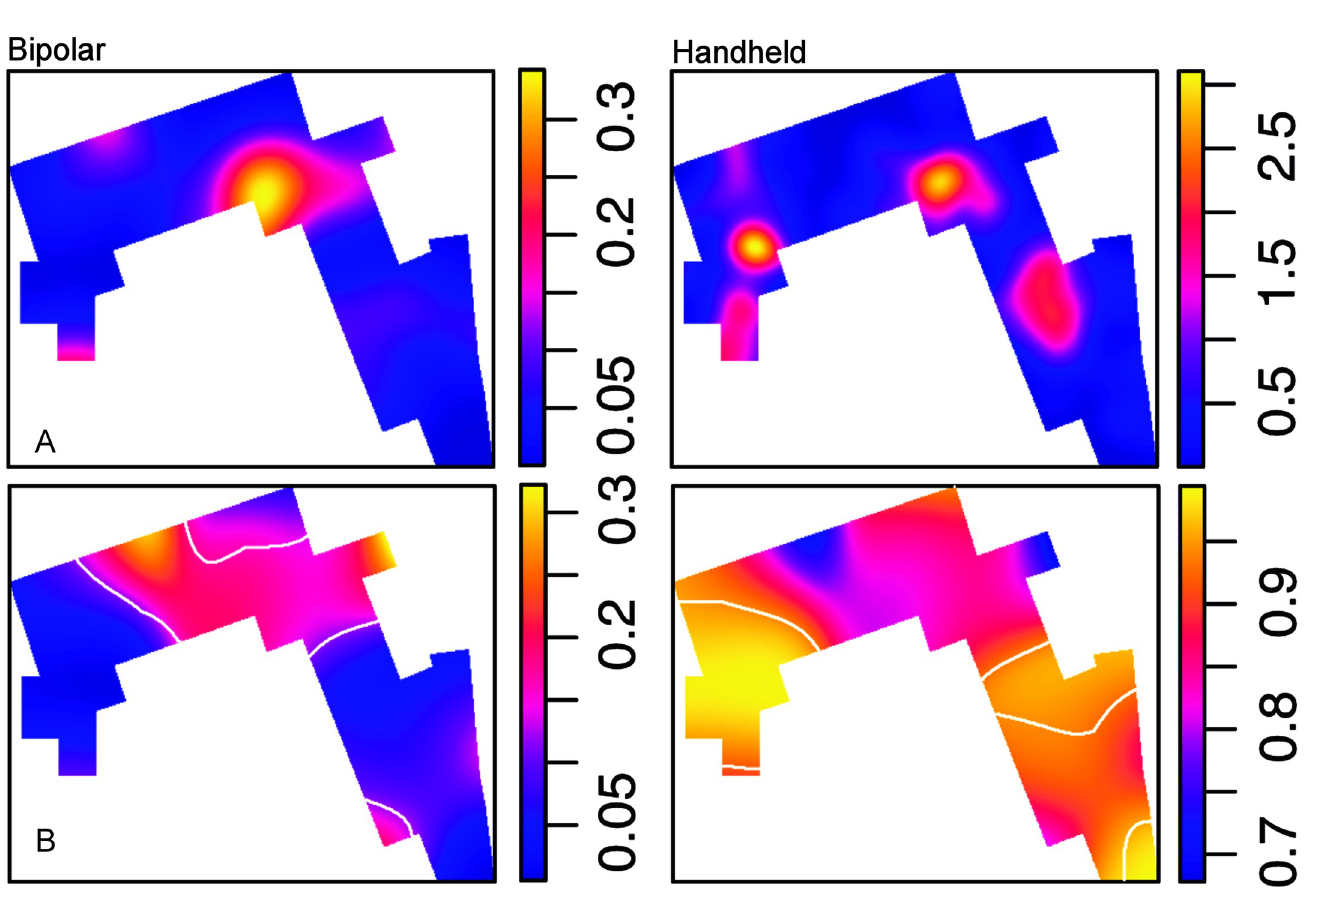
Fig 13. Bipolar and handheld knapping. A. Density maps of bipolar and handheld percussion groups. B. Maps of the relative probability distribution of both groups. Tolerance contours (white) show areas of significant deviation from the average proportion.